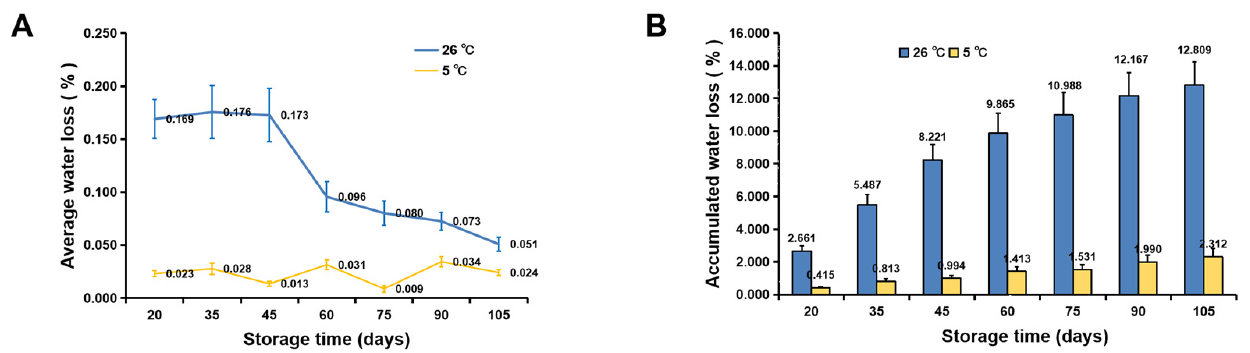
Figure 6. Water loss of navel orange fruit during storage at 26 and 5 °C. ( A ) Average water loss per fruit. ( B ) Accumulated water loss per fruit. The error bars represent the mean ± SD ( n = 20).